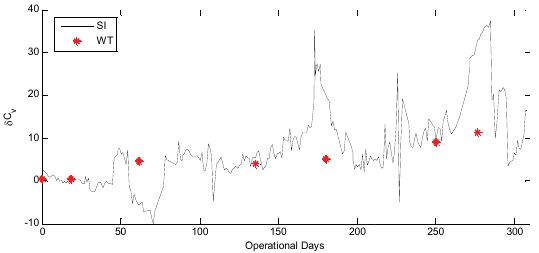
Fig. 3. Health WT